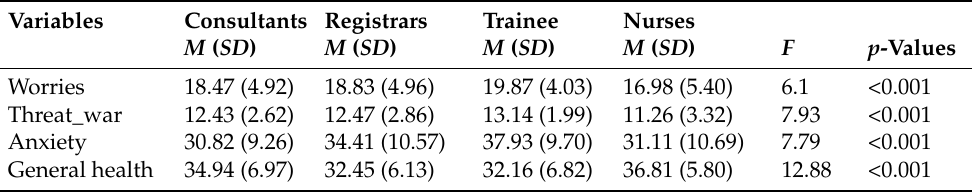
Table 2. Differences between professional categories in the main study